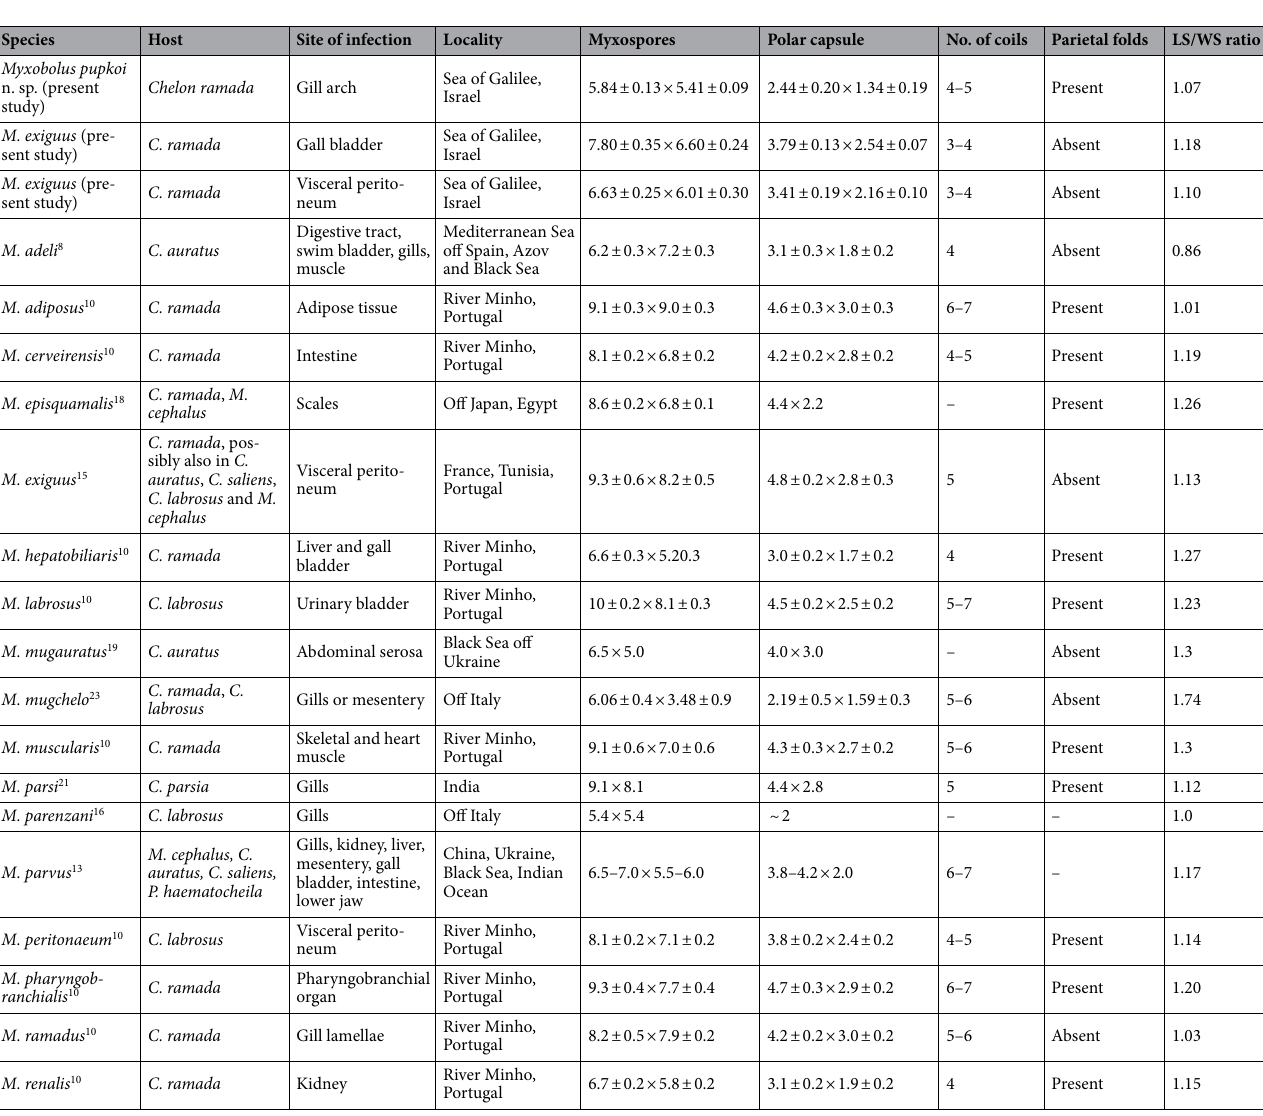
Table 2. Comparative description of Myxobolus pupkoi n. sp. with myxobolid species infecting Chelon ramada (measurements in